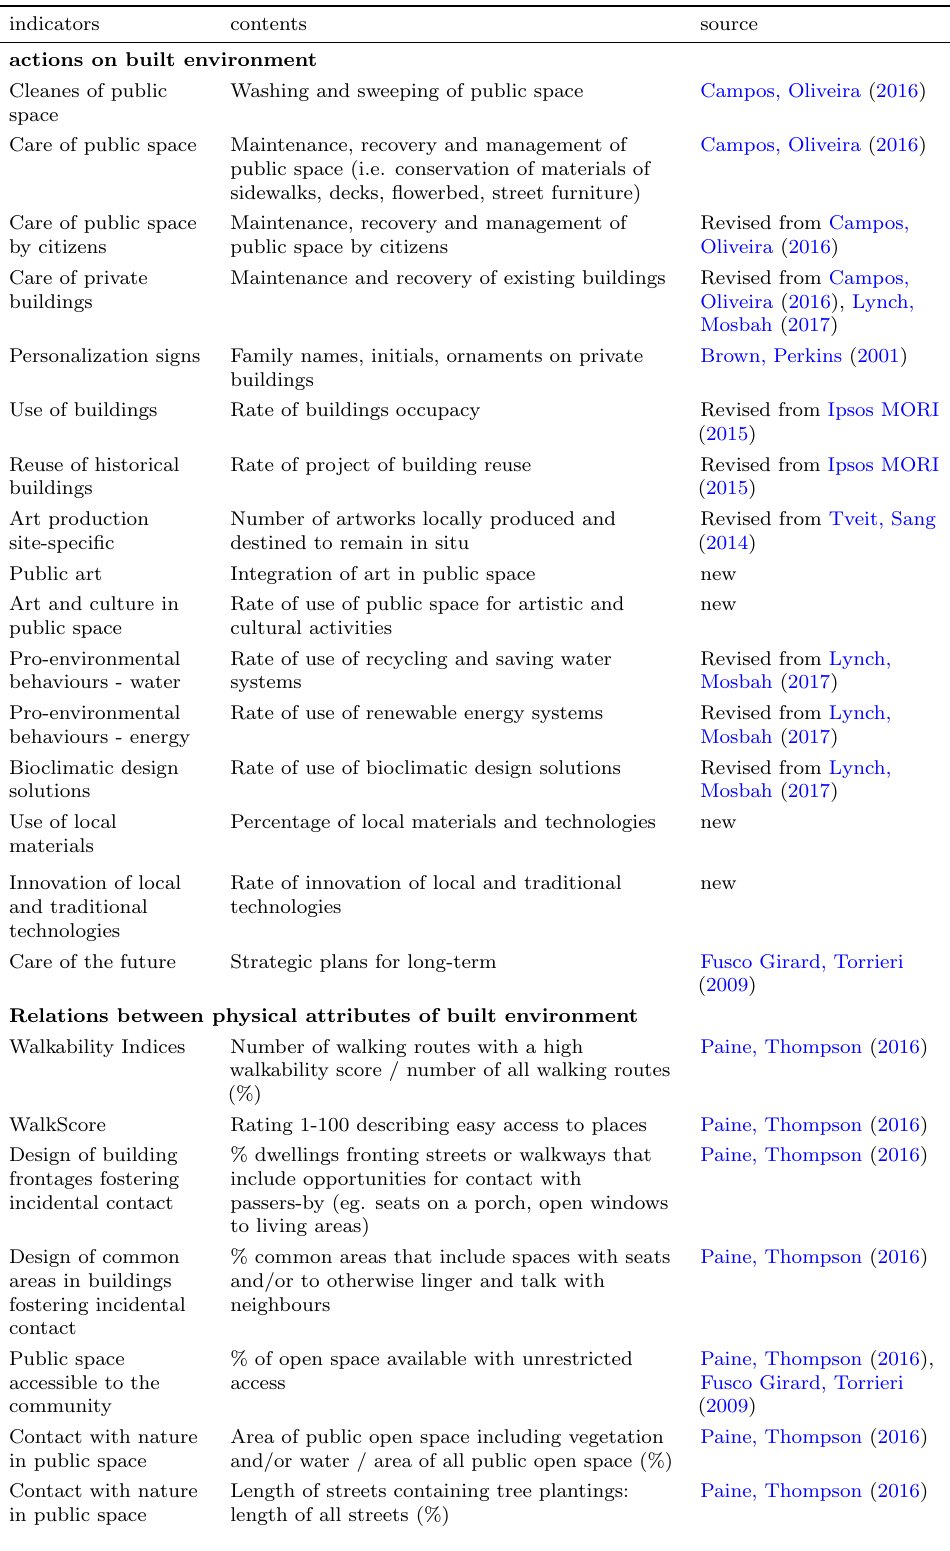
Table A.1: Relational